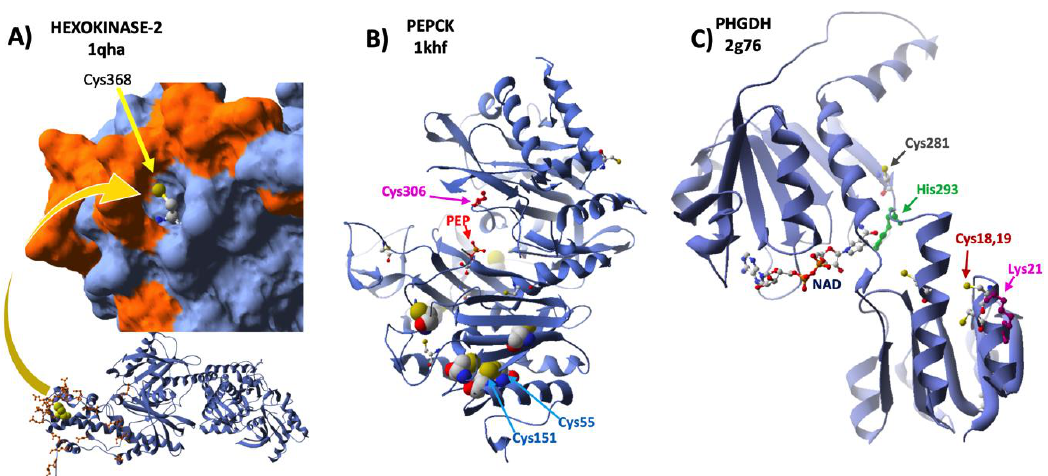
Figure 3. Structural mapping of redox sensitive Cys. The 3D structures of three enzymes of carbohydrate metabolism, HK2, PCK, and PHGDH, with the indicated PDB ID codes, were analyzed to map the Cys residues that showed significant redox changes upon Prdx6 silencing in HepG2 cells. ( A ) One subunit of HK2 is shown below in a ribbon model with Cys368 atoms as yellow Van der Waals spheres and sidechains of residues involved in interaction contacts with VDAC1 highlighted in orange; the C-terminus is enlarged in molecular surface mode, except for Cys368, with the same highlighting criterium as below. ( B ) PCK in ribbon mode and detected Cys residues with atoms as Van der Waals spheres, color CPK; one molecule of substrate PEP (red) is bound at the active site; the positions of Cys306, Cys55 and Cys151 are indicated with arrows. ( C ) PHGDH in ribbon cartoon with the coenzyme NAD bound at the active site cleft; sidechains of redox modified Cys residues upon Prdx6 silencing are shown in CPK color; acetylation and sumoylation sensitive Lys21 is shown in purple next to redox sensitive Cys18-Cys19; catalytic His283 is shown in green with the redox sensitive Cys281 in the neighborhood.